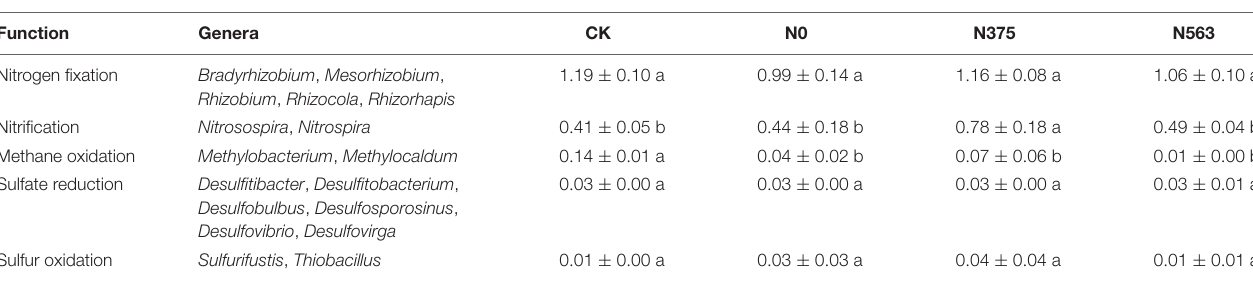
Values represent mean ± standard deviation of triplicate measurements. Values within the same row followed by different lowercase letters indicated significant differences (P < 0.05) according to Duncan’s multiple comparison tests. CK, without fertilization; N0, without N fertilization; N375, application of 375 kg/ha N; N563, application of 563 kg/ha